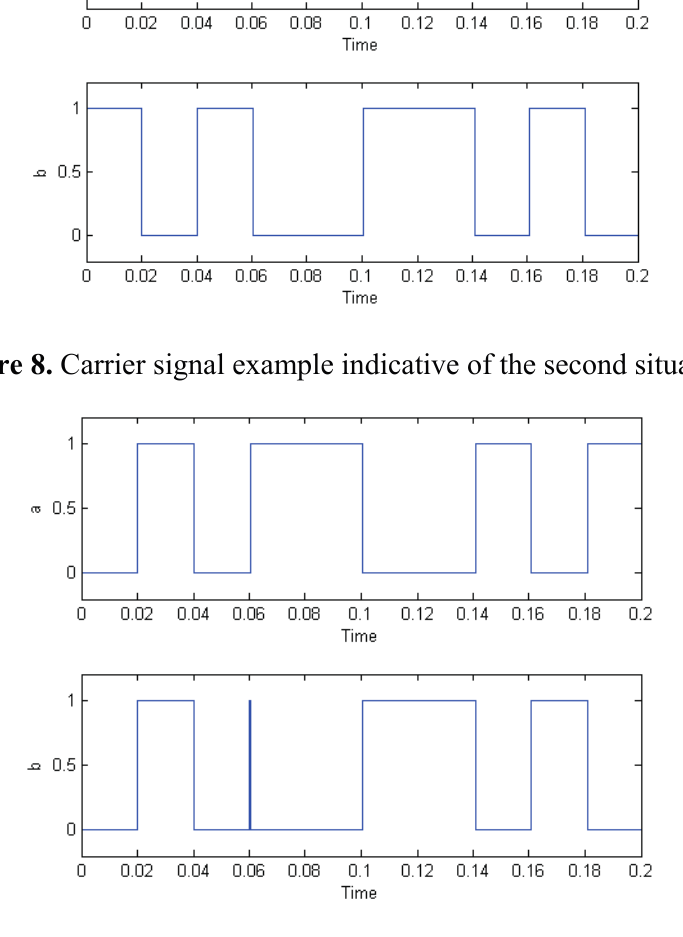
Figure 9. Carrier Signal of the third